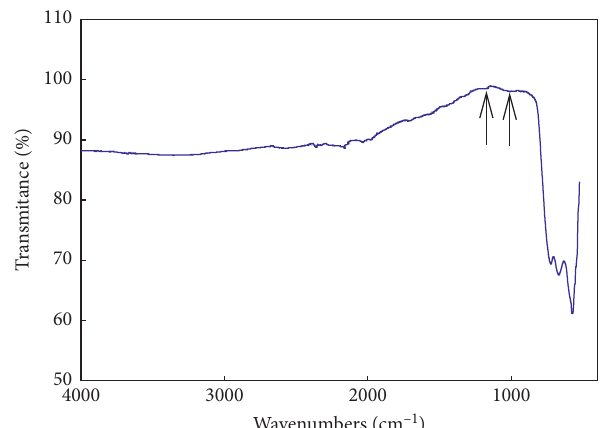
Figure 4: IR spectrum of m-ZrO